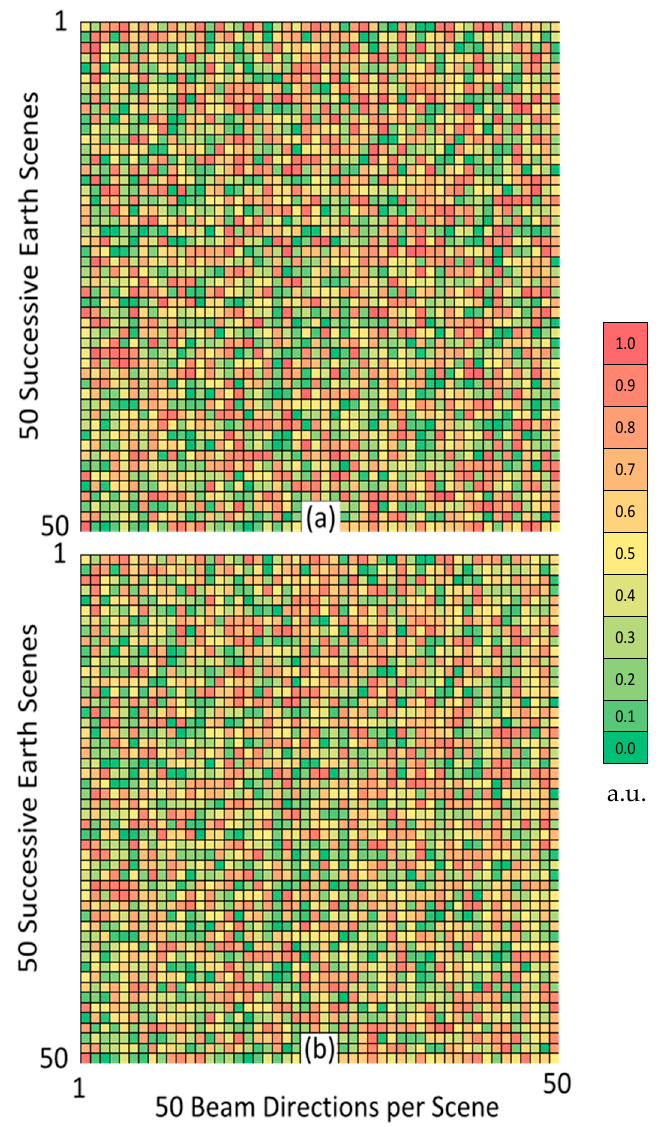
Figure 10. Each row represents ( a ) a random relative intensity distribution incident to the entrance aperture from 50 directions and ( b ) the corresponding directional relative intensity distribution produced by the ANN.